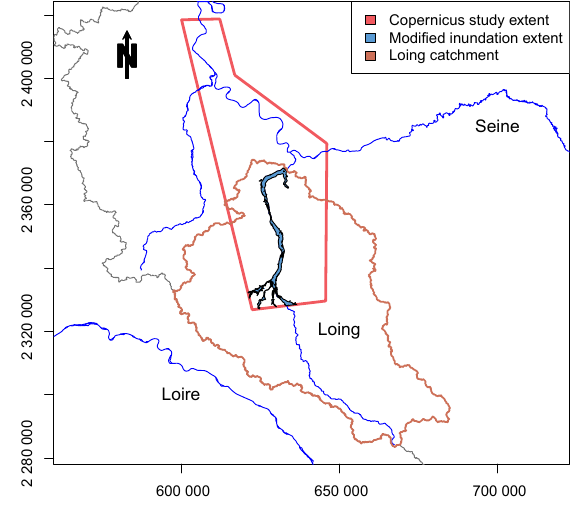
Figure 6. Maximum flood extent for the May–June 2016 event over the Loing catchment produced by the Copernicus Emergency Man- agement Service.